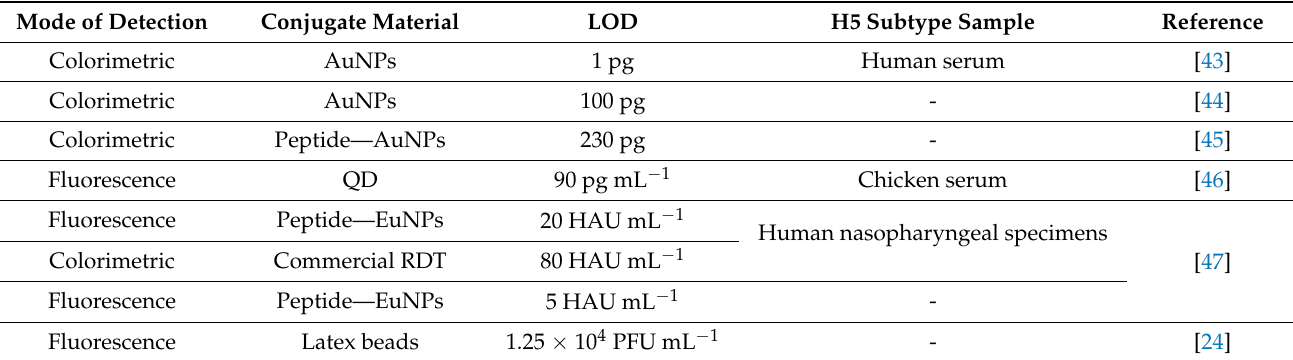
Table 1. Single-mode detection approach for AIV H5 subtypes with LOD.